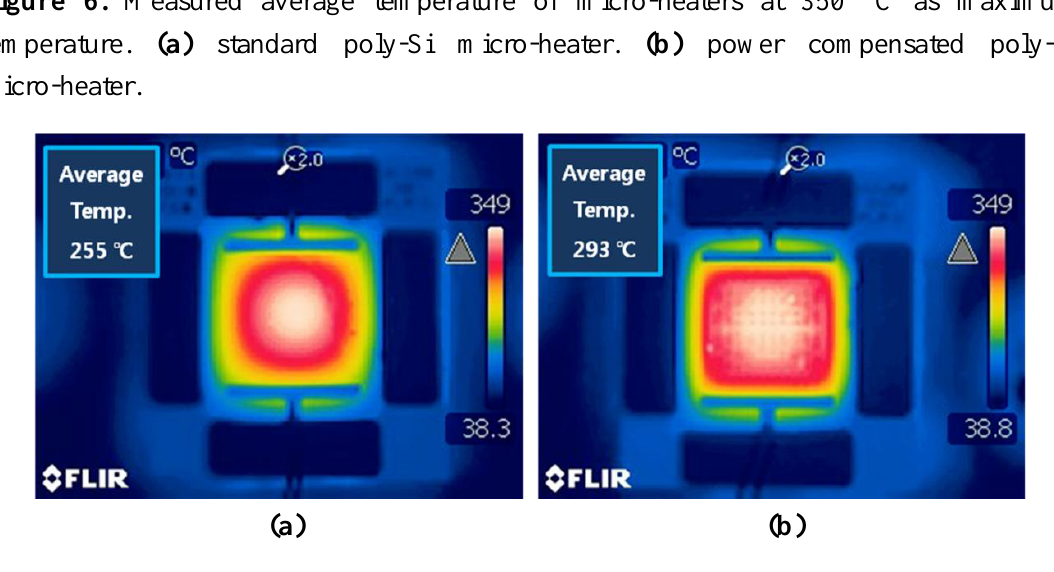
Figure 7. Measured within 10% of high temperature distribution of micro-heaters at 350  C as maximum temperature. (a) standard poly-Si micro-heater. (b) power compensated poly-Si